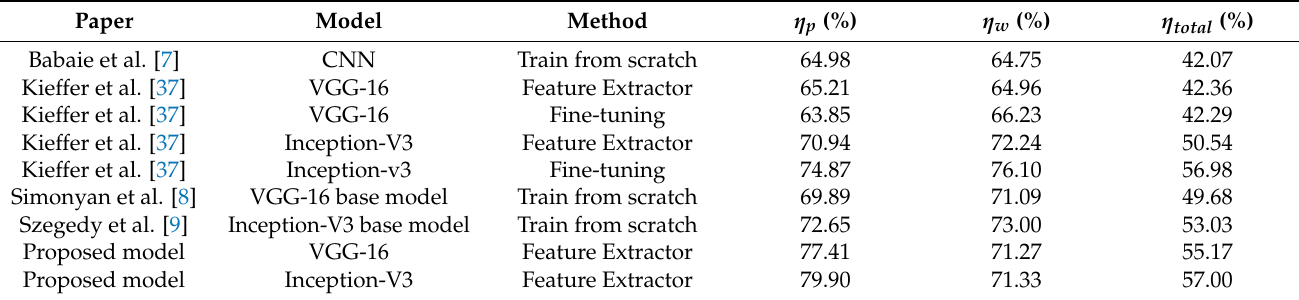
Table 2. Comparison of proposed innovation with famous state-of-the art